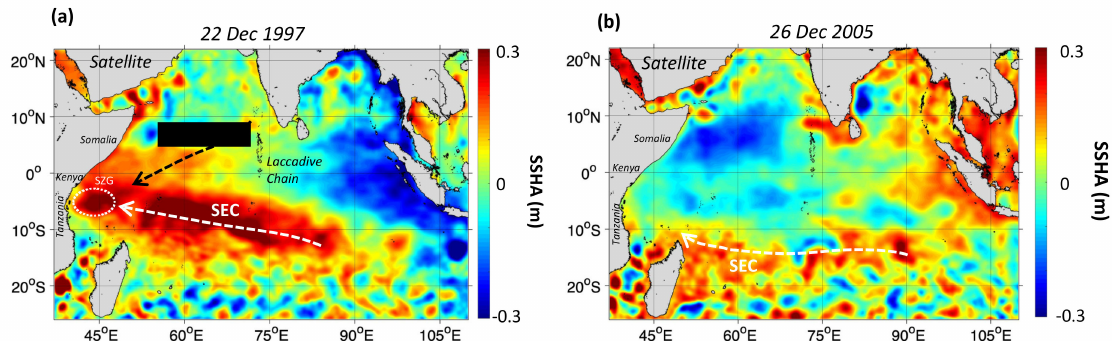
Figure 4. Formation of the Somali–Zanzibar Gyre (SZG) during 1997–98 El Niño and IOD + . Satellite Sea Surface Height Anomalies (SSHA) (m) over the Indian Ocean from ( a ) on the 22 December 1997 (a super El Niño year) and ( b ) 26 December 2005 (a non-El-Niño year). A schematic of the convergence of the “Laccadive High / Northeast flow” (LH / NE) and Southern Equatorial Current (SEC) flows is superimposed on panel ( a ) in dashed black and white arrows and the SZG detaching from the main SEC flow is indicated with a dotted circle.